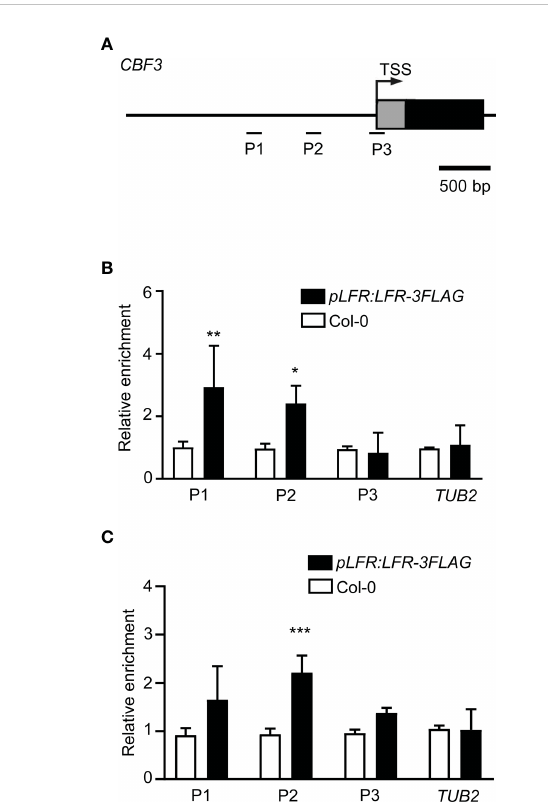
FIGURE 4 LFR binds to CBF3 chromatin. (A) The gene structure of CBF3 . Black boxes indicate exons; lines represent the promoter or intergenic region. Fragments ampli fi ed in the ChIP-qPCR assay are marked by short lines below the gene model. TSS, transcription start site. (B, C) ChIP-qPCR assay of LFR binding to CBF3 without (B) and with low- temperature treatment (C) . Error bars indicate the SD of three biological replicates. *P < 0.05, **P < 0.01, ***P<0.001, Student ’ s t (Supplementary Figure S1A). And we also checked the transcript level of LFR in plants treated with or without cold exposure at different time points. RT-qPCR showed that LFR was downregulated by cold treatment (Figure 6B). We also studied the protein level of LFR using pLFR : LFR - eYFP / lfr-2 complemented lines. Furthermore, when the pLFR : LFR - eYFP / lfr-2 lines were held at 4°C, the eYFP signals were reduced, especially after 6 and 24 h of cold stress (Figures 6C – E). Taken together, these results indicate that LFR may be repressed by cold stress.